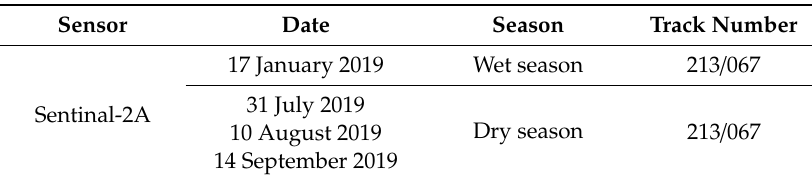
Table 2. The collection of the remote sensing data.